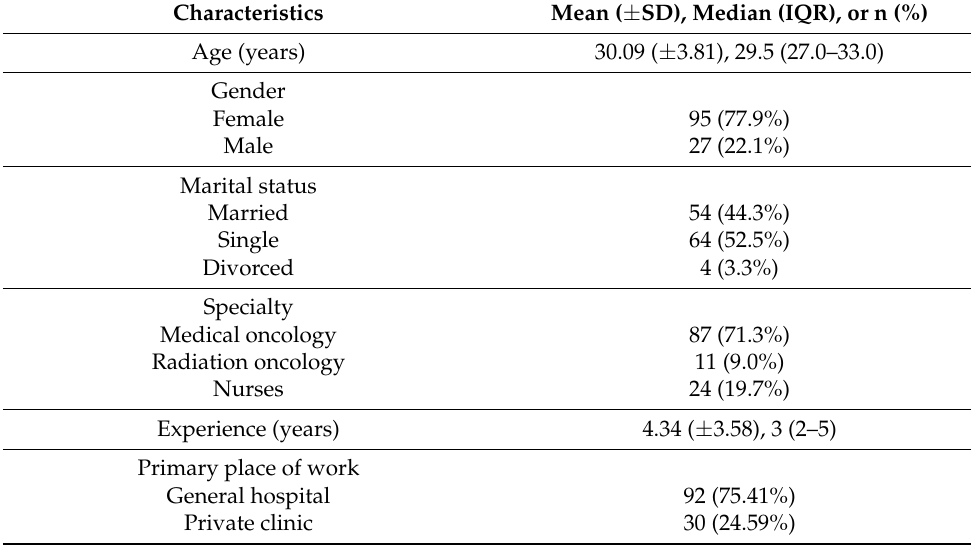
Table 1. Participants’ demographic characteristics (n = 122).